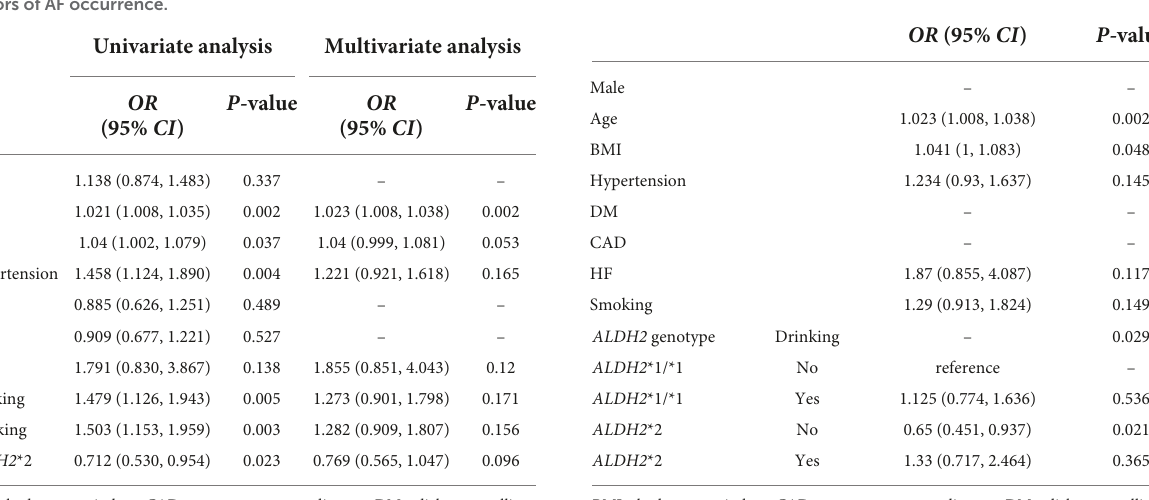
TABLE 4 The association of the variable combined ALDH2 genotype and drinking with AF occurrence in the multivariate